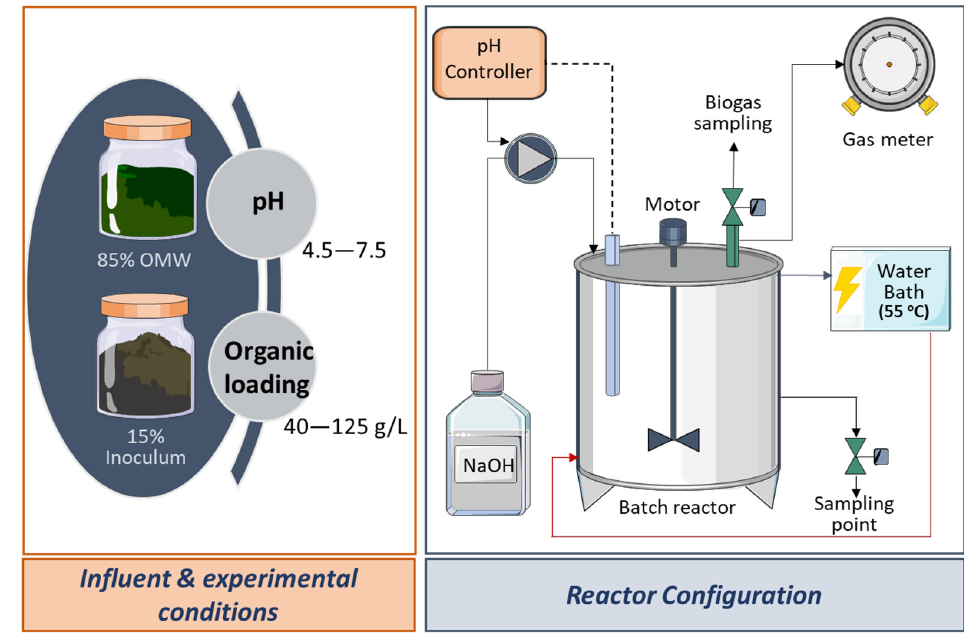
Figure 1. Influent and experimental conditions, and reactor configuration for the thermophilic DF of OMW.